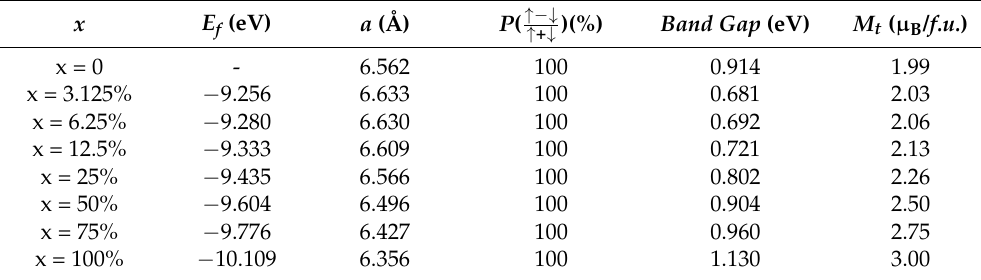
Table 1. Formation energies ( E f ), lattice parameters (unit in